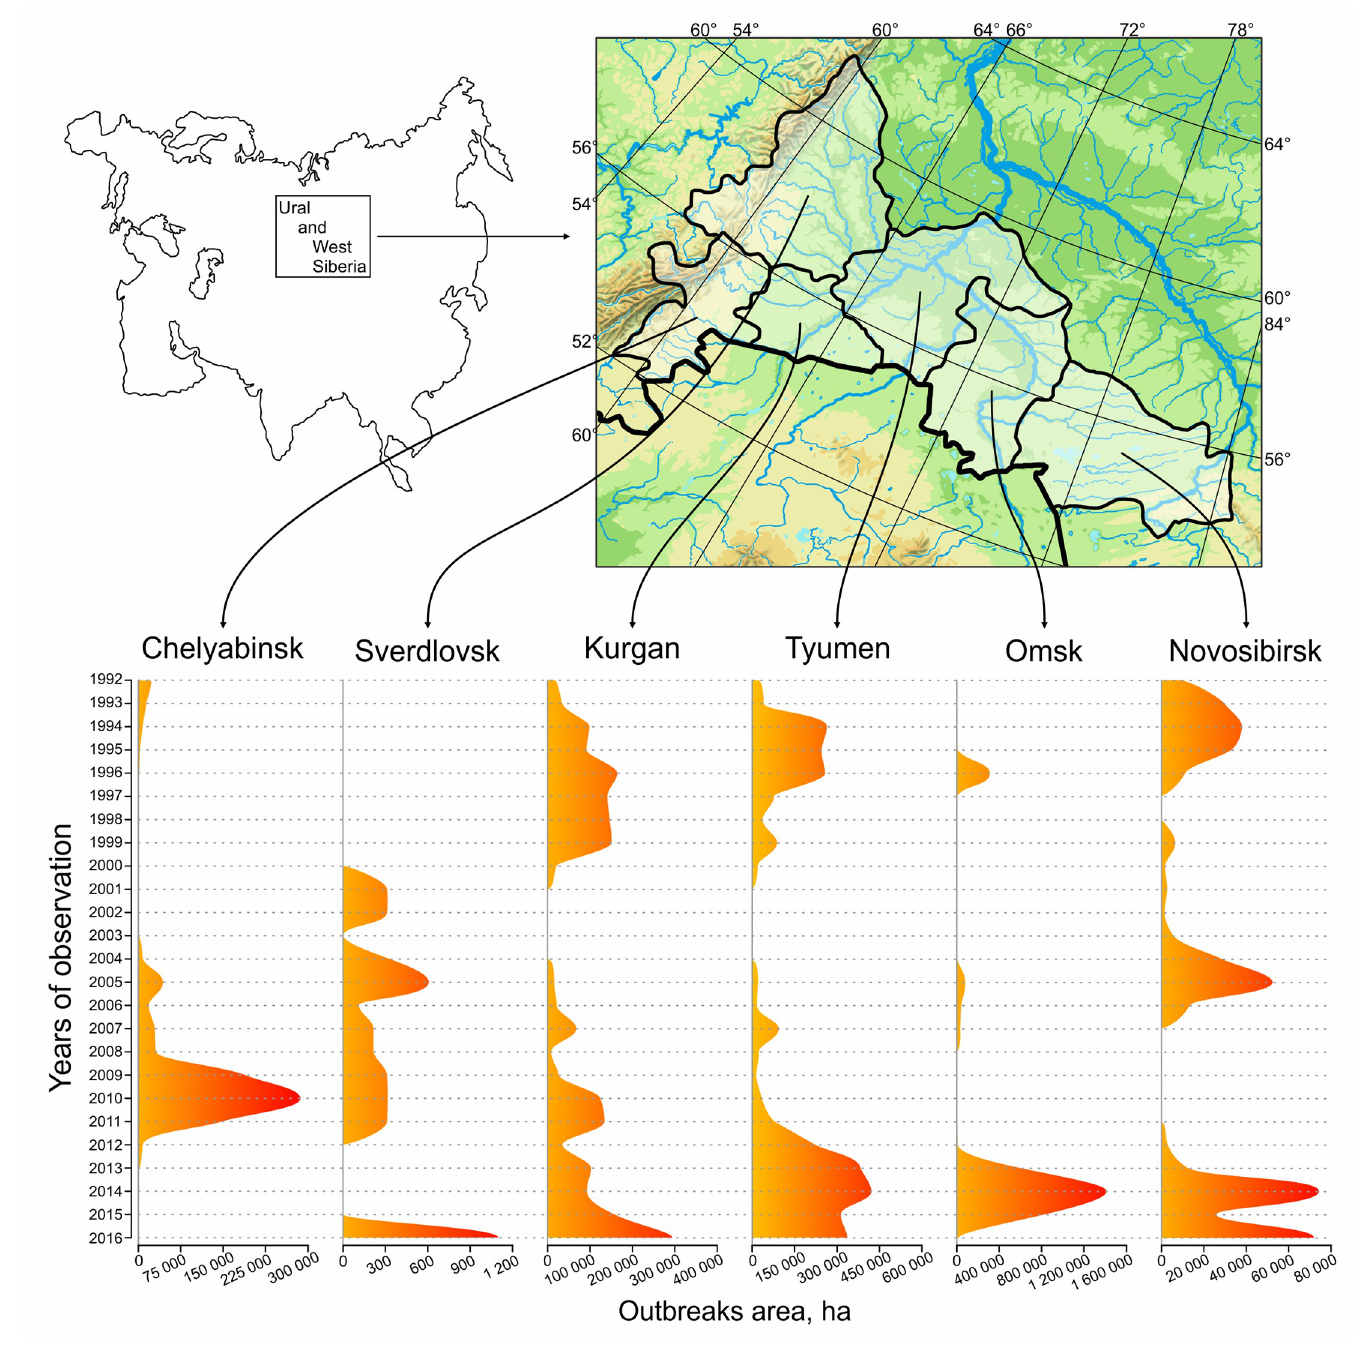
Fig 2. Time-series data of Lymantria dispar outbreak areas in administrative oblasts of Russia in West Siberia. https://doi.org/10.1371/journal.pone.0220954.g002 The absence of a time delay indicates that the time series are synchronous such that k = 0 and the value p (0) ! 1. The time series are coherent with a delay equal to the value of k if xy the maximum of the cross-correlation function falls on the value, k = ± 1 , k = ± 2 , etc. and the